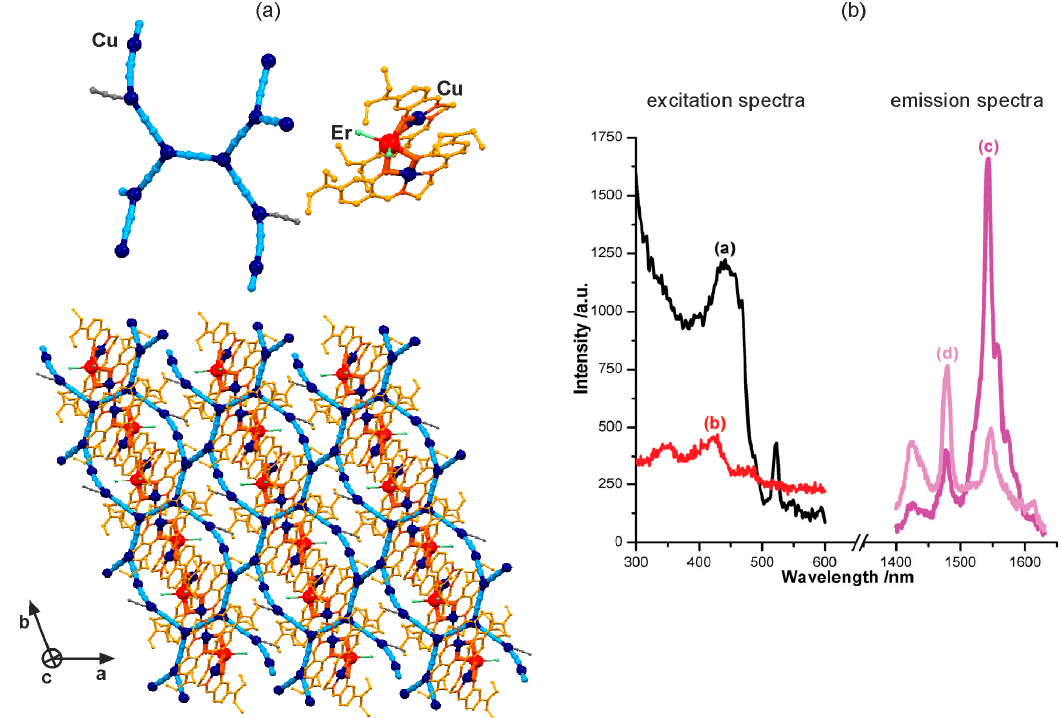
Figure 11. Crystal structure and optical properties of supramolecular [Er III Cu II 2 (L1) 2 (Cl) 2 ][Cu I 4 (CN) 5 (MeCN) 4 ] (L1 = N,N’-ethylene bis[4-(ethylamino)salicylideneimine anion) network: ( a ) the structural views of two main components, including the fragment of the cyanido-bridged Cu I -based layer and the {Er III Cu I2 } molecule, and their arrangement in the supramolecular network, (b) the room temperature excitation and emission spectra of the reference cyanide-free {ErIII2(H2L)4} molecule (black and purple lines), and the presented supramolecular network (red and light purple lines). Colours for the structural diagram: Er, red; Cu, dark blue; CN − , blue; L1, orange; Cl − , light green. Adapted from Ref. [120] with permission from The Royal Society of Chemistry.